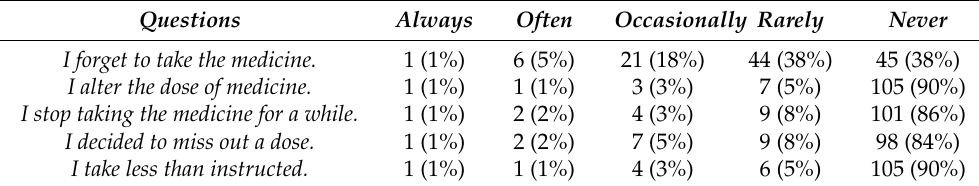
Table 2. Distribution of adolescent responses in MARS questionnaire.